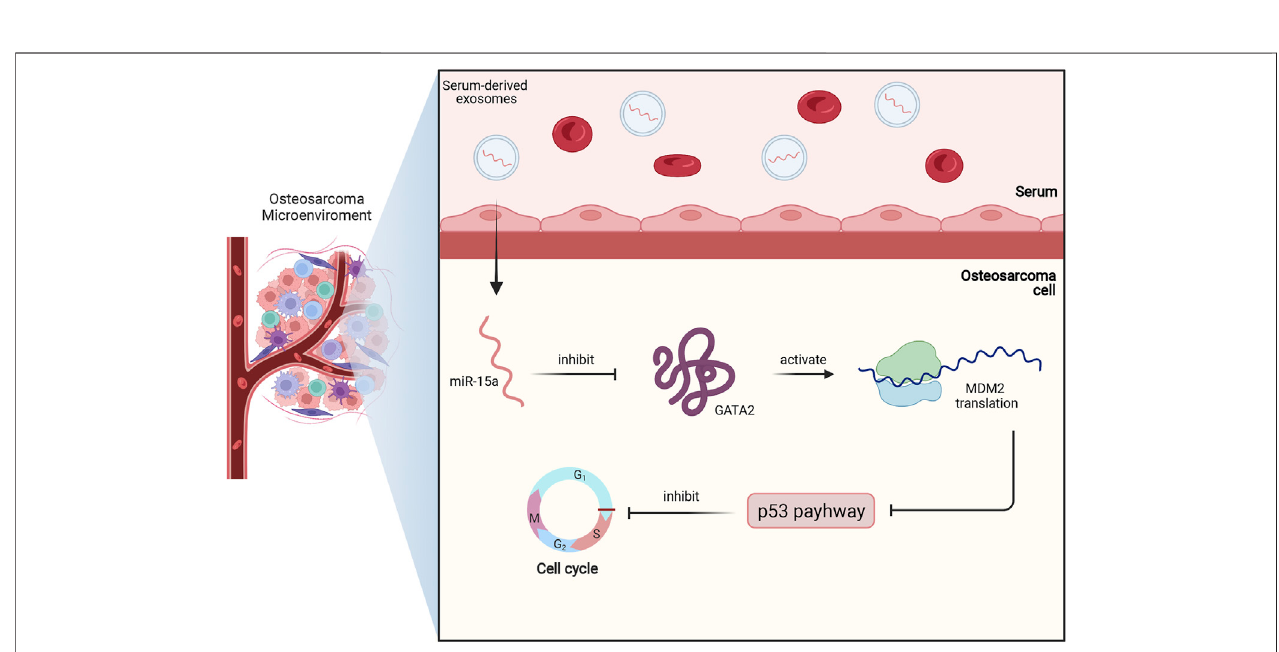
FIGURE 4 | This fi gure brie fl y shows miR-15a/GATA2/MDM2/p53 axis in osteosarcoma. Firstly, miR-15a is transported to osteosarcoma cells by serum-derived exosomes, and then miR-15a directly binds to GATA2 and inhibits its expression. Subsequently, the downregulated expression of GATA2 downregulates the MDM2 translation and activates the p53 signaling pathway. Finally, the activated p53 pathway contributes to cell cycle arrest and apoptosis of osteosarcoma.